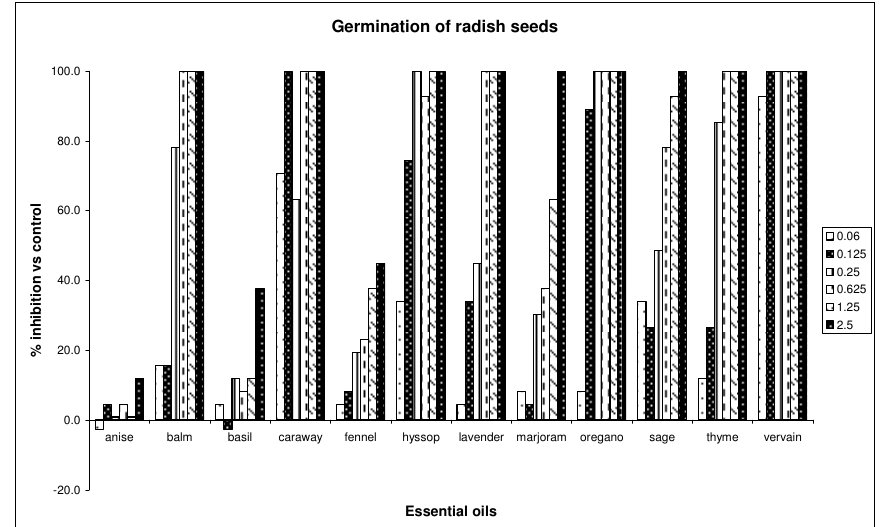
Figure 2. Percent inhibition of germination of Raphanus sativus seeds treated with different doses of essential